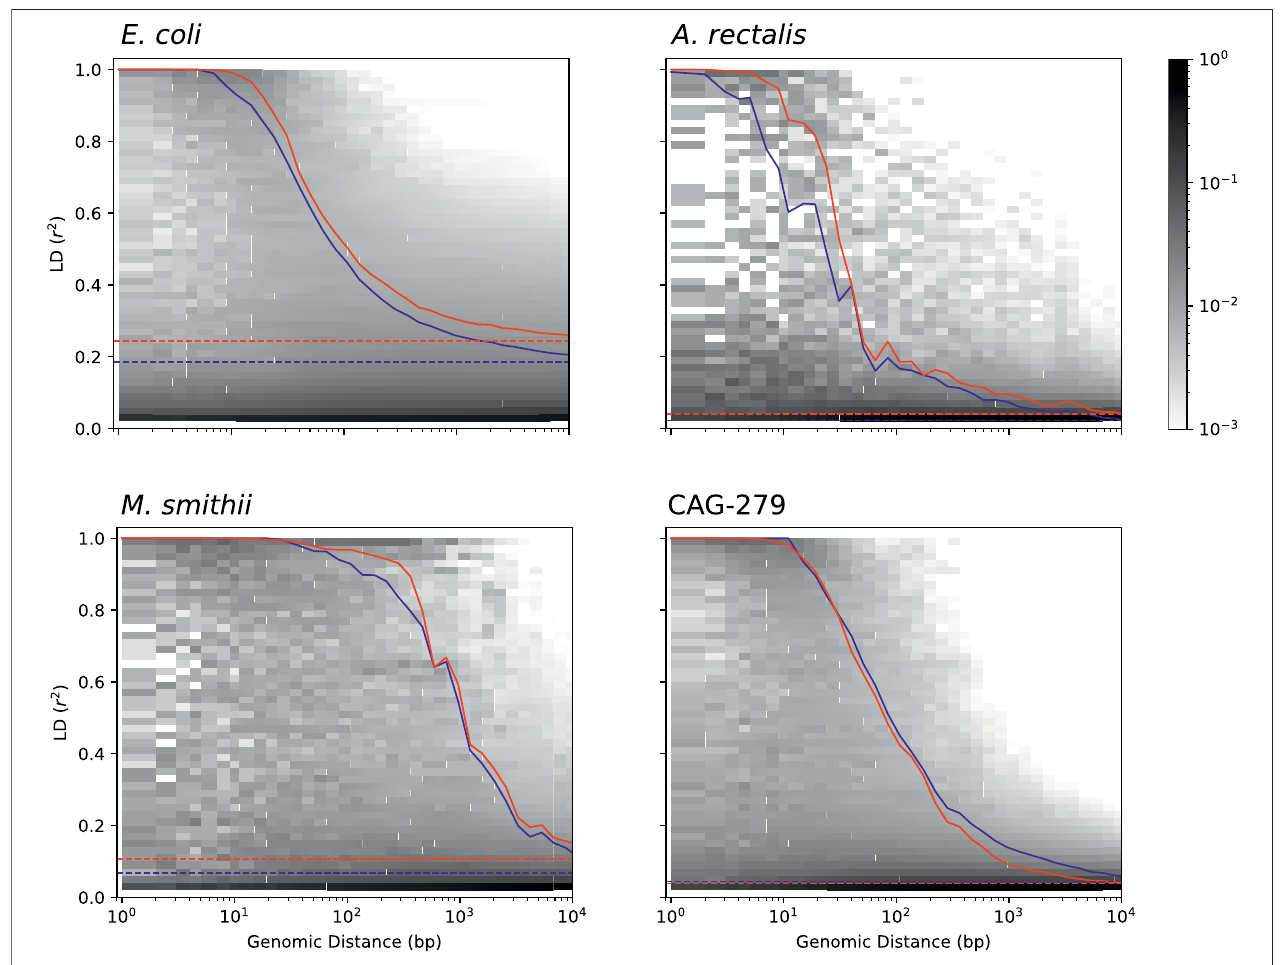
FIGURE 6 | Pairwise LD across genomic distance estimated from inferred genotypes for four species. LD was calculated as r 2 and genomic distance between polymorphic loci is based on distances in a single, representative genome. The distribution of SNP pairs in each distance window is shown as a histogram with darker colors re fl ecting a larger fraction of the pairs in that LD bin, and the LD 90 for pairs at each distance is shown for inferred strains (red), along with an identical analysis on strains in the reference database (blue). Genome-wide LD 90 (dashed lines) is also